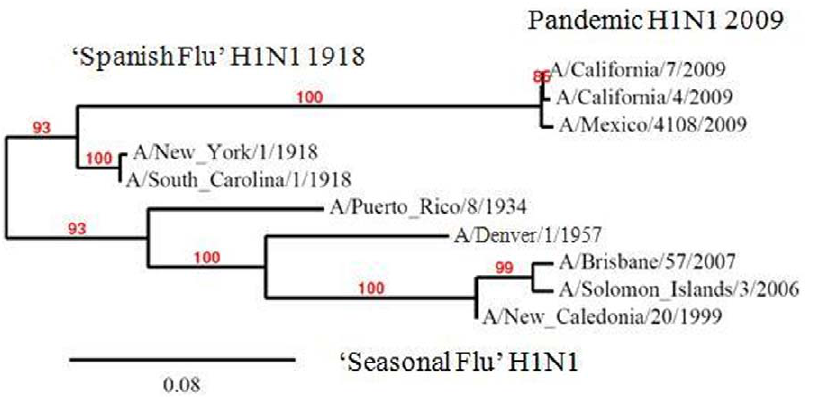
Figure 4. Genetic relatedness of HA from historical strains of influenza H1N1. The tree includes select H1N1 influenza isolates of the classic swine and human influenza lineages (see Materials and Methods for database accession numbers). Phylogenetic trees were inferred from hemagglutinin amino acid sequences using the maximum likelihood method. Bootstrap analysis values are shown above the branches. The scale bar indicates the number of amino acid residue changes per unit length of the horizontal